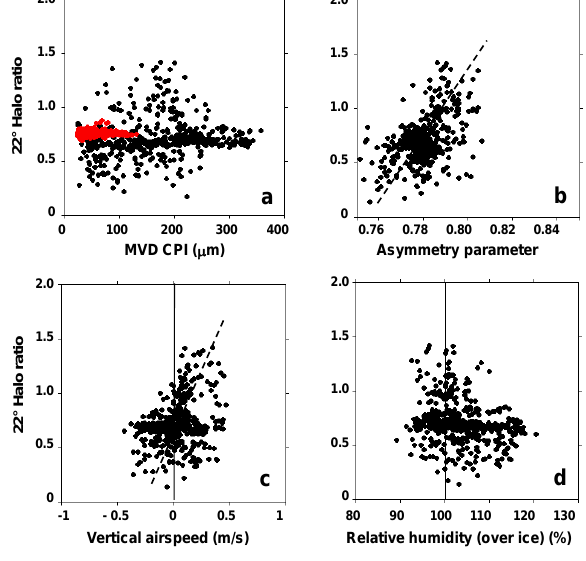
Fig. 5. Scatter plots of the halo ratio versus: (a) the mean volume diameter from CPI (DVM), (b) the asymmetry parameter, (c) the relative humidity over ice and (d) the vertical airspeed. The data relate cirrus with 22 ◦ Halo occurrence (case B, see Fig. 3). The red points in Fig. 5a concern the cirrus with no 22 ◦ Halo occurrence (case A, see Fig.